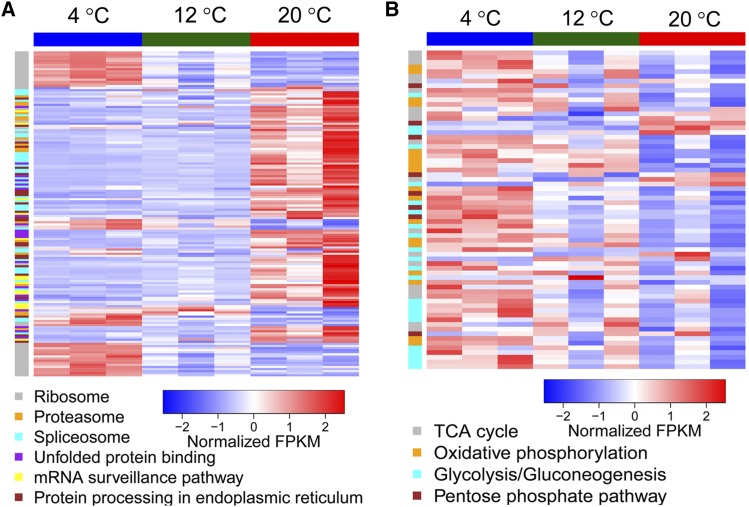
(A) Heatmap of differentially expressed genes (DEGs) involved in transcription, post-transcriptional regulation, translation, and post-translational regulation. (B) Heatmap of DEGs involved in energy metabolism.